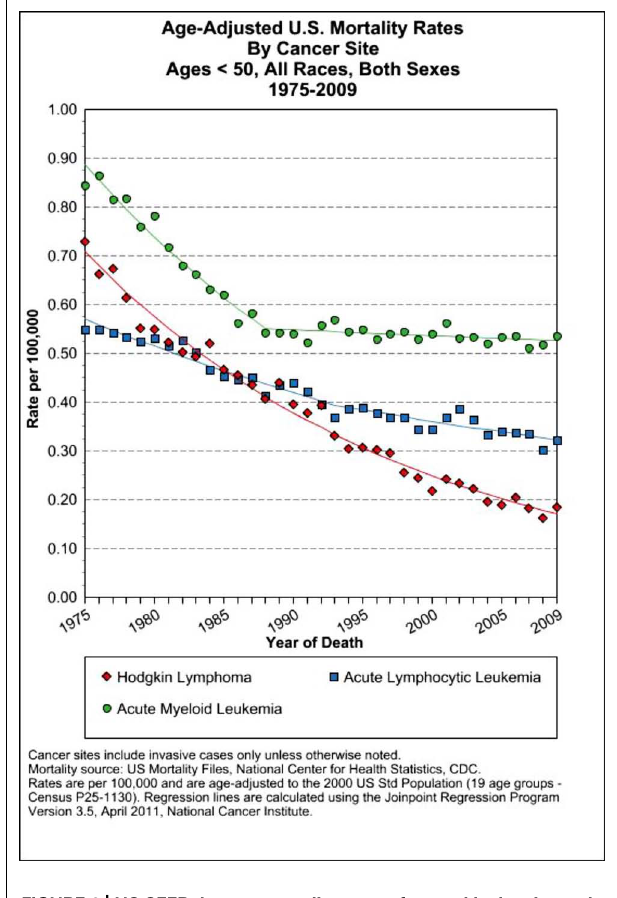
FIGURE 6 | US SEER data on mortality rates of several leukemias and Hodgkin’s lymphoma that have seen a precipitous decline since 1975 resulting from dose-dense combined chemotherapy MTD therapies (Howlader etal.,